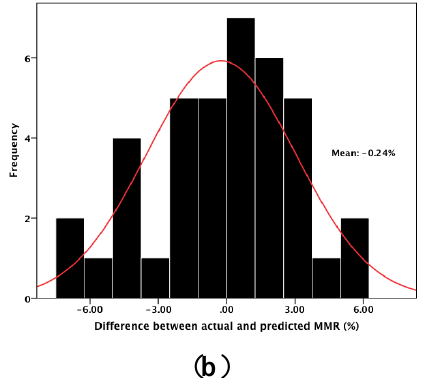
Figure 5. Results of model validation. ( a ) CBR; ( b )